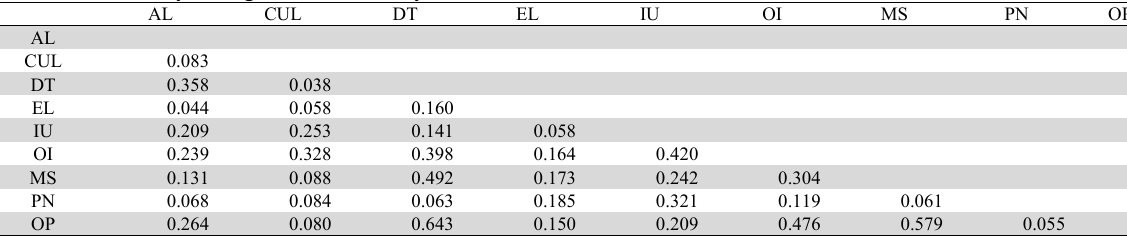
Discriminant validity through HTMT of Study